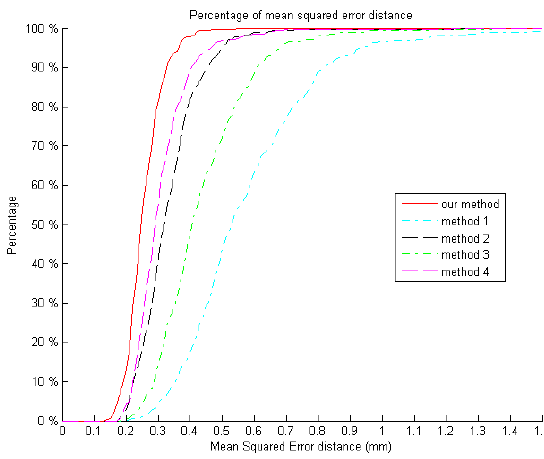
Fig. 20. Cumulative percentages of the within-class Mean Squared Error Distance of neutral faces.